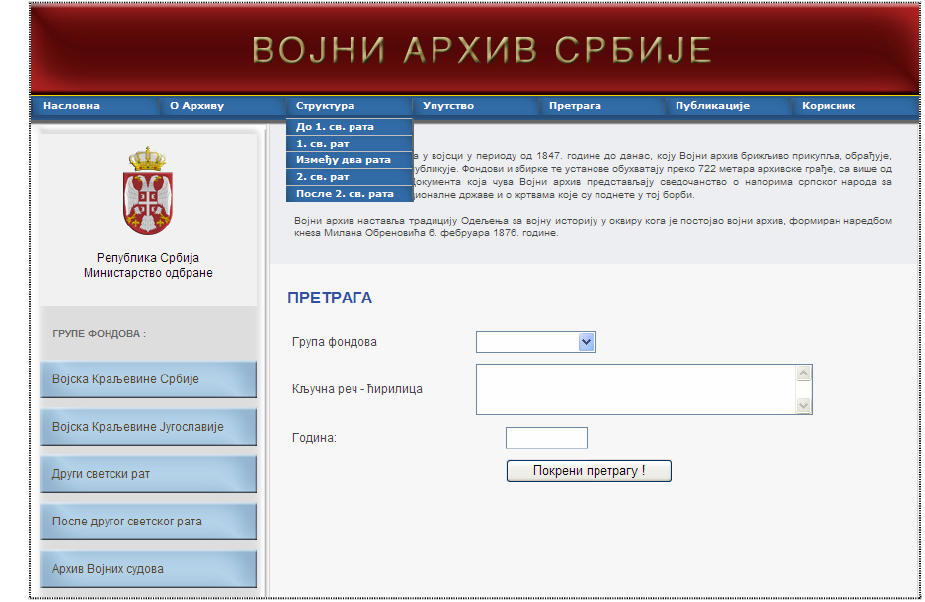
Figure 13 – ADA application home page for the survey of digitized